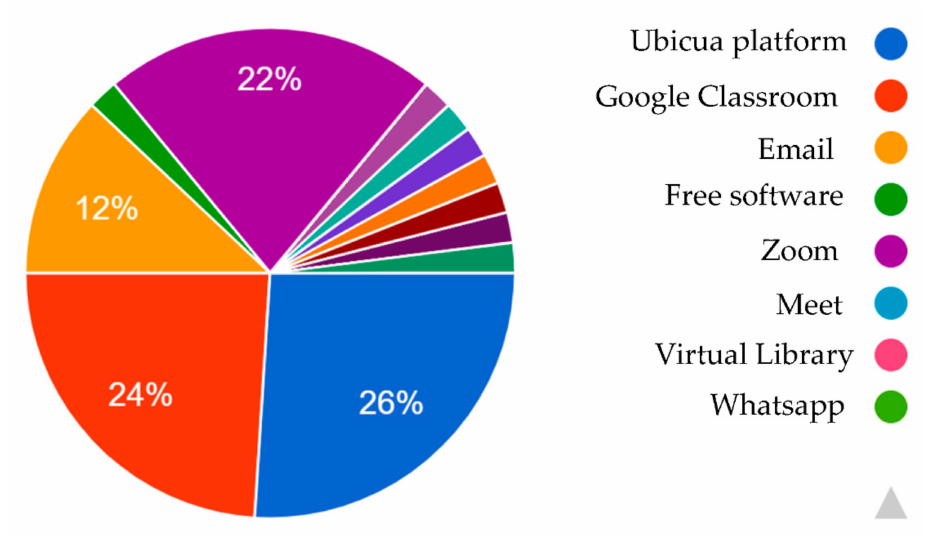
Figure 3. Technological tools in remote learning (professors).